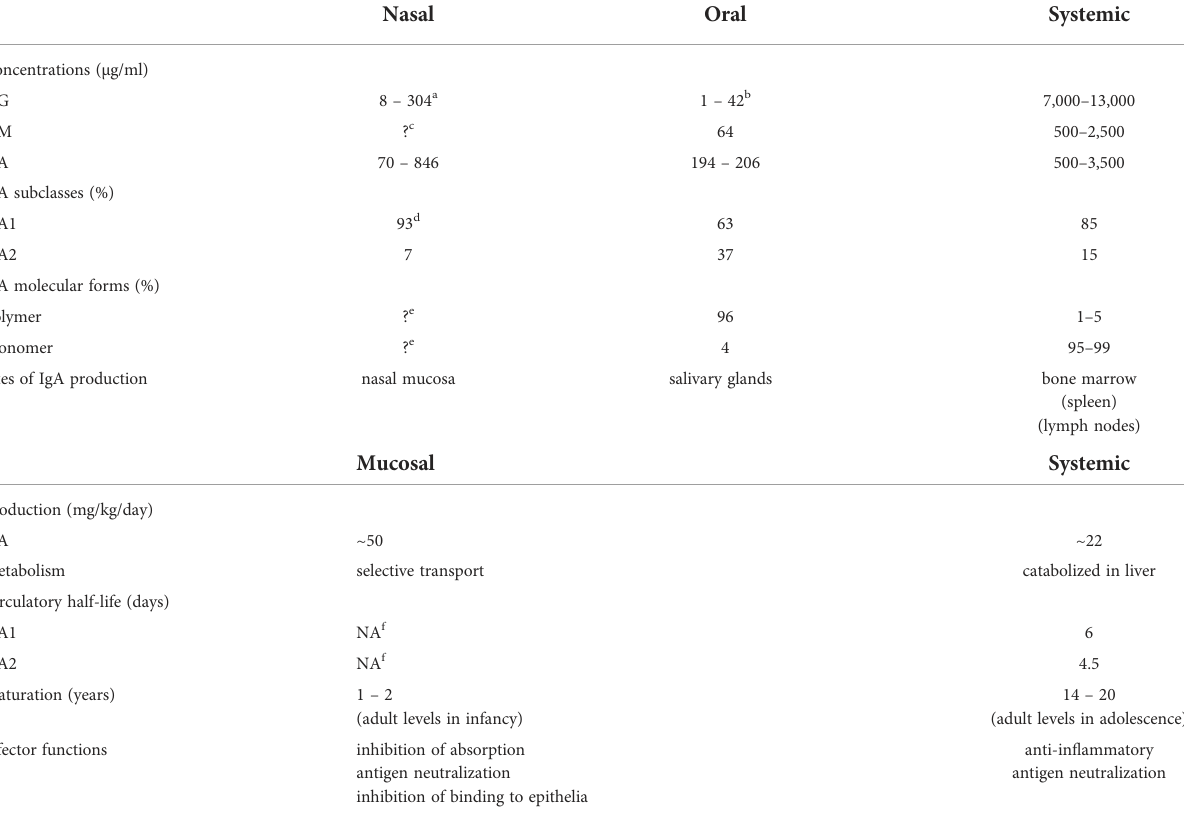
TABLE 1 Comparative properties and differences between mucosal (oral and nasal) and systemic immune